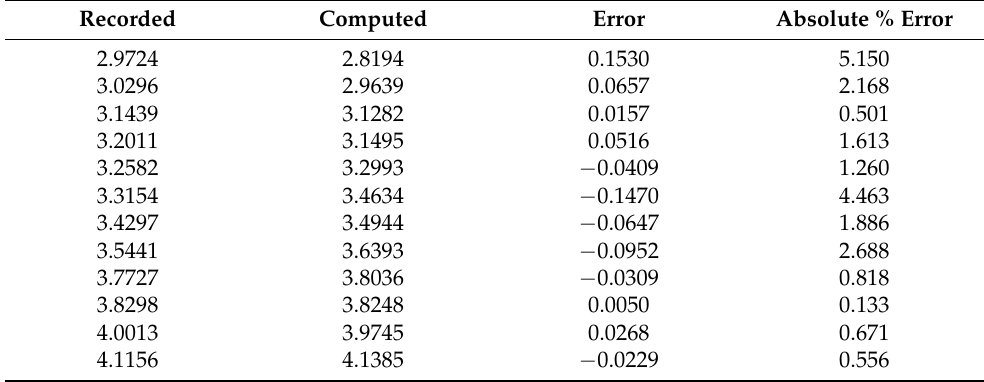
Table 6. Recorded and computed values in the GRNN on the Test set for the bronze sample. Recorded Computed Error